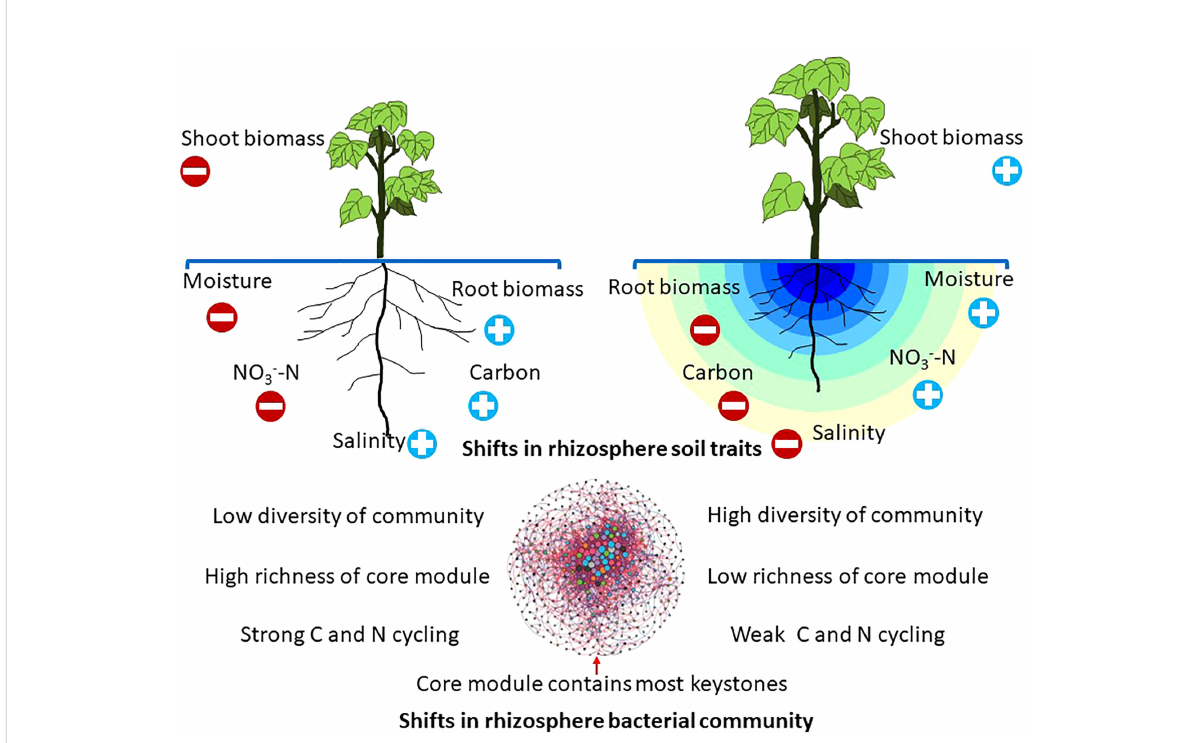
FIGURE 6 A theoretical framework exploring the effects of different practices on bacteria (structure, functional potential) in relation to multiple factors. Practices affect plant growth and rhizosphere soils, which in turn in fl uence the rhizosphere bacterial community. The richness of the core module can be altered by agricultural practice. The pivotal changes in the bacteria-driven nutrient process are